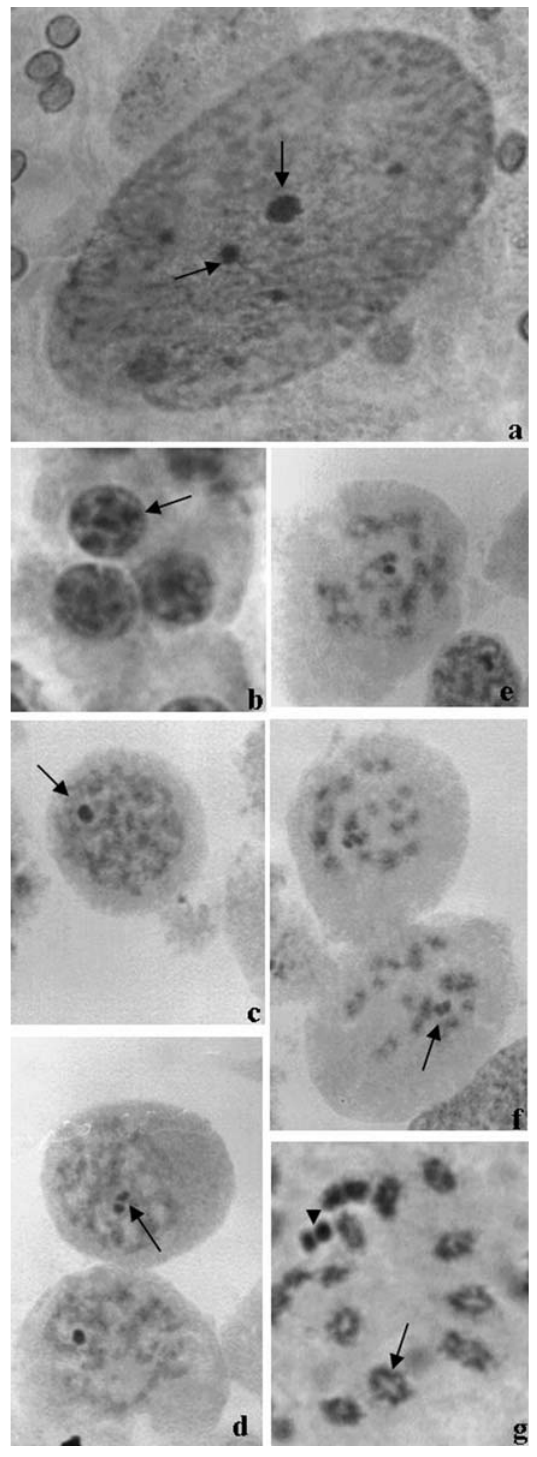
Figure 2 - Testicular tubules of Triatoma klugi after lacto-acetic orcein staining. (a) Polyploid nuclei with on average five heteropycnotic corpus- cles, arrows indicate corpuscles; (b) Spermatogonial interphase cells with six pycnotic corpuscles, the arrow indicates the corpuscles; (c-d) Nuclei at the beginning of prophase I (diffuse stage) presenting one or two con- densed corpuscles formed by the sex chromosomes, arrows indicate cor- puscles; (e-f) Nuclei in early prophase I, sexual corpuscle is indicated by arrow; (g) Nucleus in diplotene-diakinesis, arrow indicates bivalent auto- somesandthearrowheadpointstothepseudobivalentsexchromosomes.